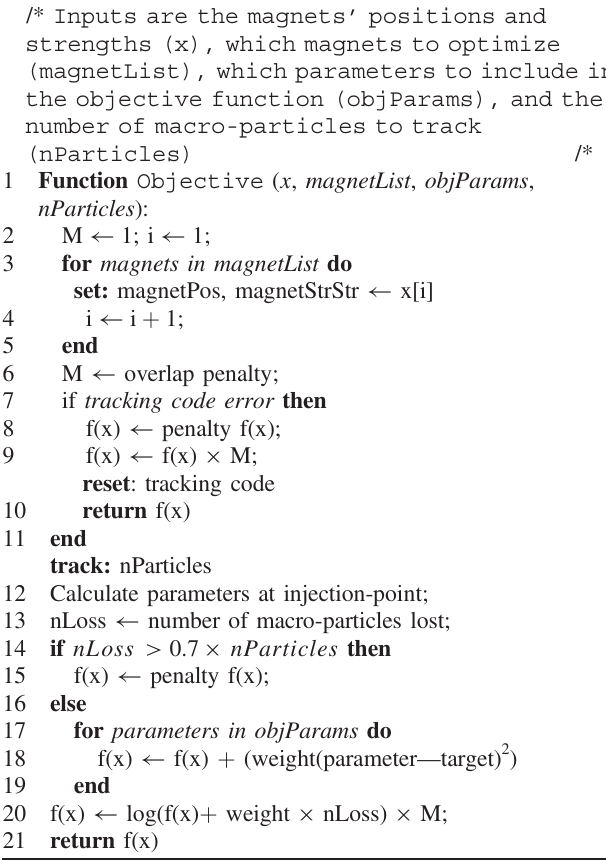
Algorithm 1: Calculation of the objective function used to optimize magnet positions (Pos) and strengths